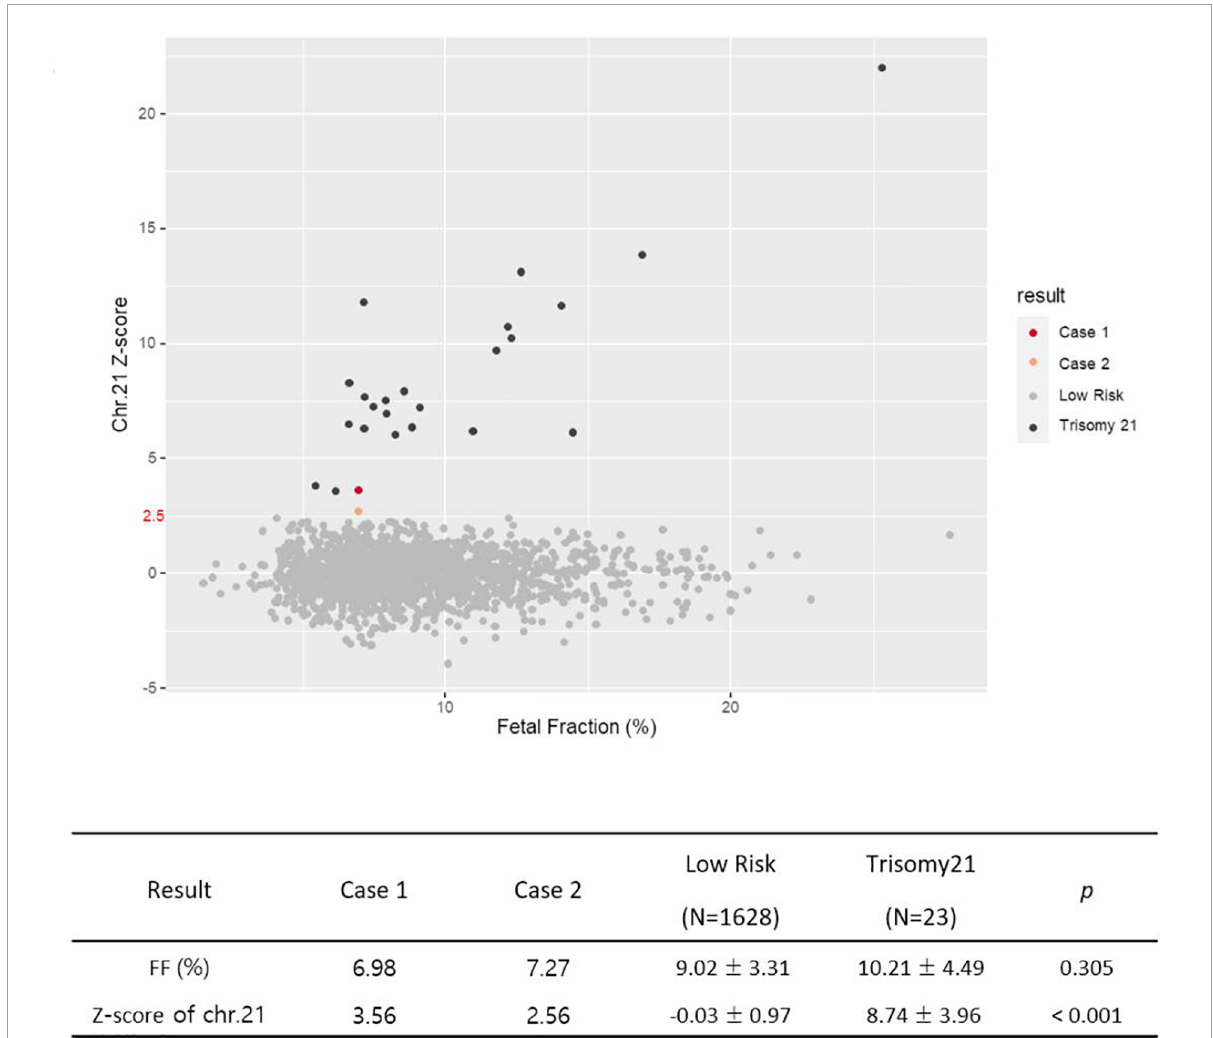
FIGURE8 Z-score for chromosome 21 of 1,653 data from Jan 2019 to December